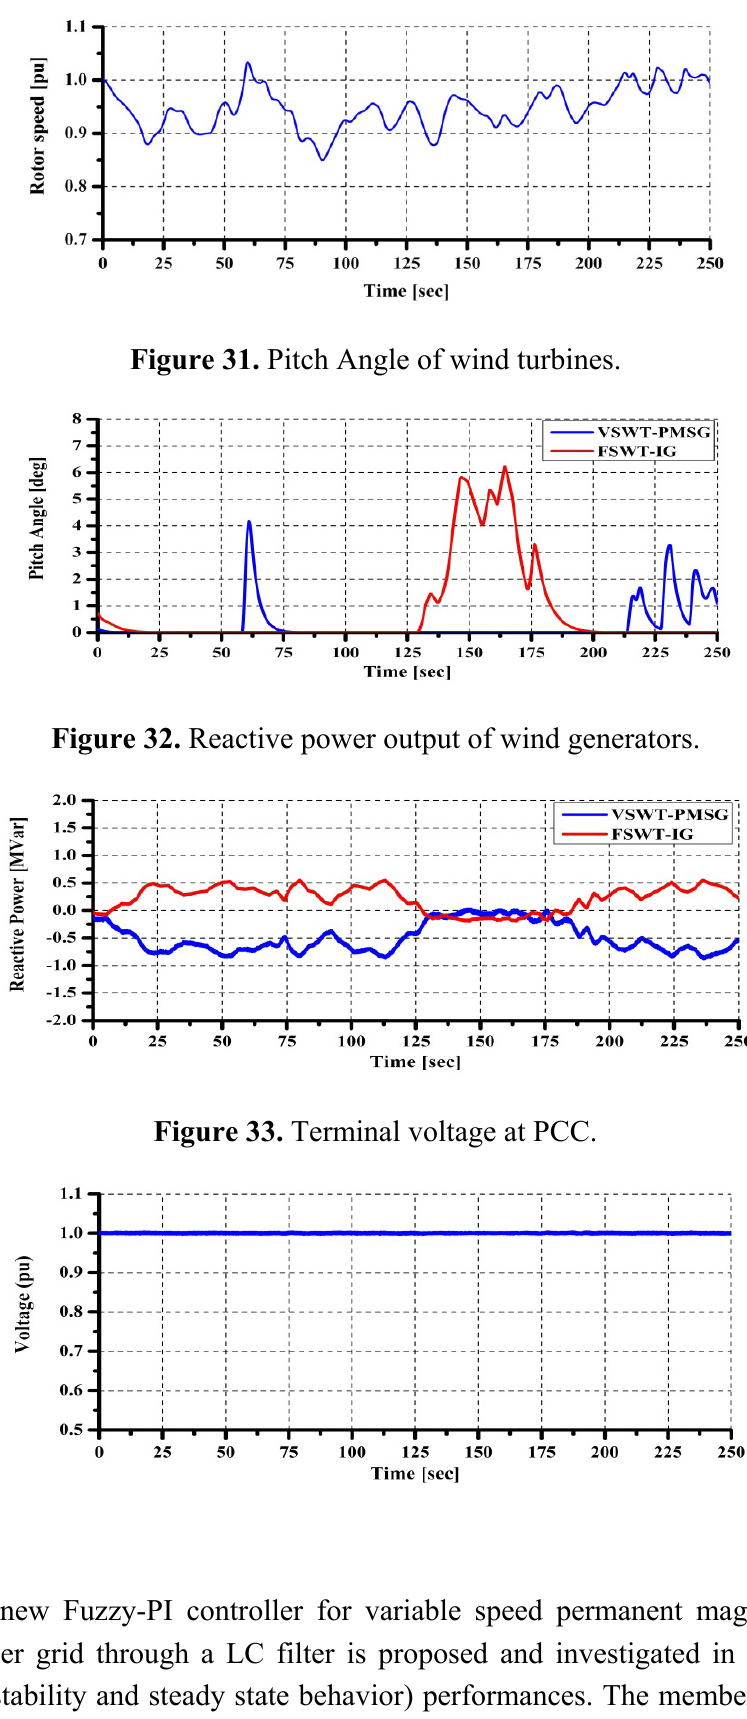
Figure 30. Rotor speed response of VSWT-PMSG.